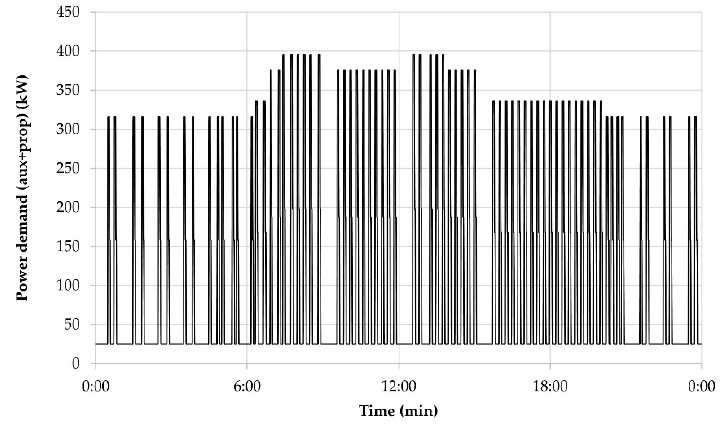
Figure A1. Power demand profile of the ferry chosen as a case study [39].